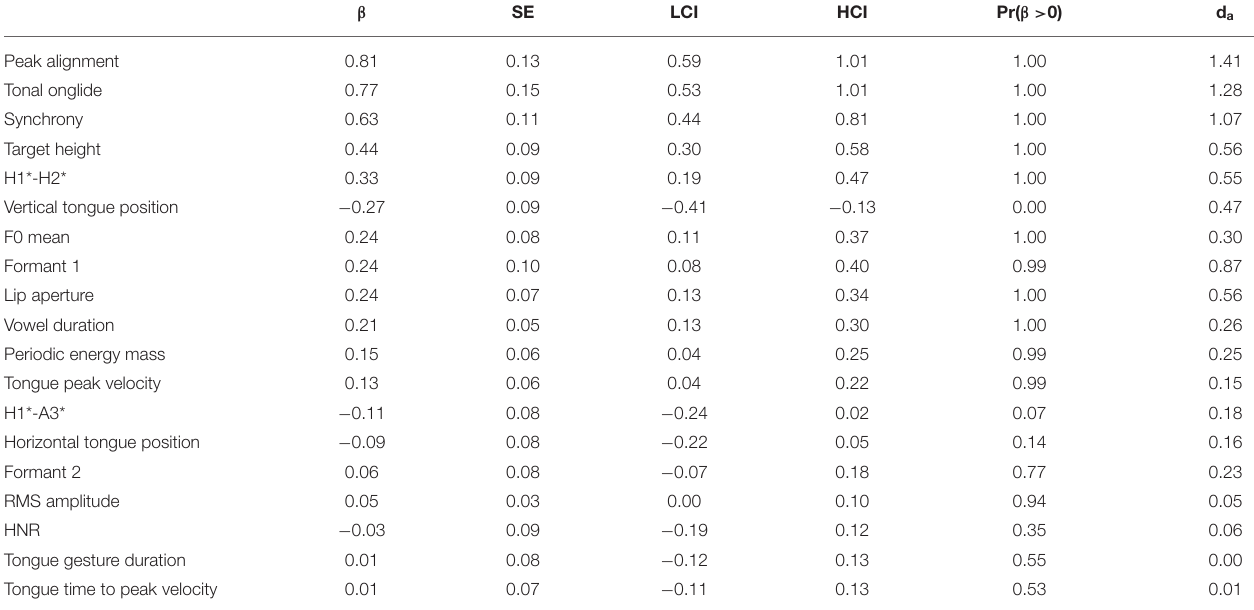
TABLE 5 | Tabular overview of modeling results for broad vs. contrastive focus, vowel /a/. LCI and HCI refer to the low and high boundaries of the 90% Credible Interval.